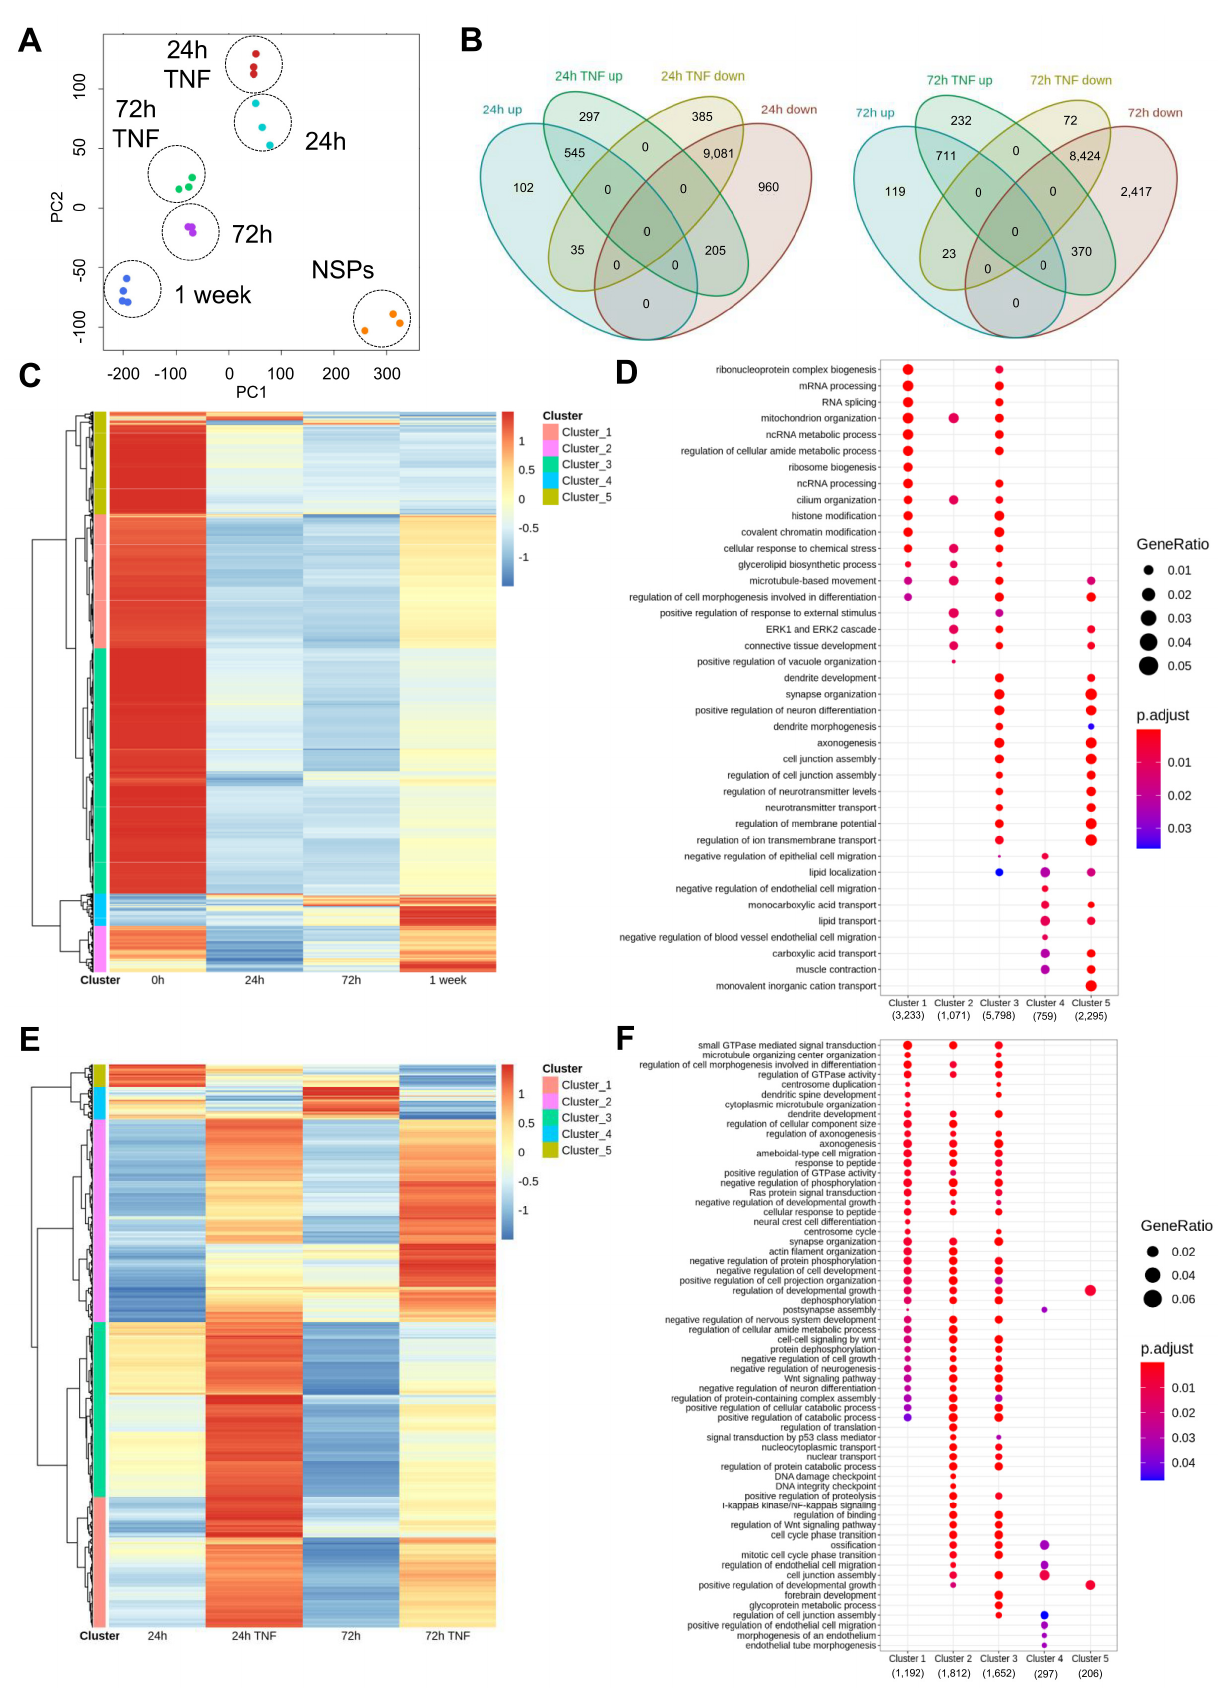
Figure 4. Chromatin accessibility profile of differentiating astrocytes under normal and